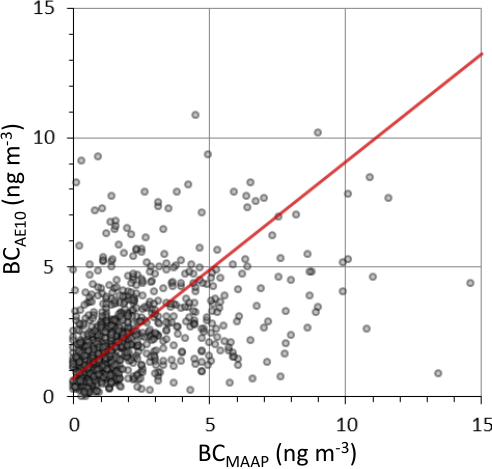
Fig. 3. RMA regression of BC concentrations (daily medians) measured by the AE10 and the MAAP. Slope=0.82 ± 0.03, inter- cept=0.86 ± 0.1, r 2 =0.19, n